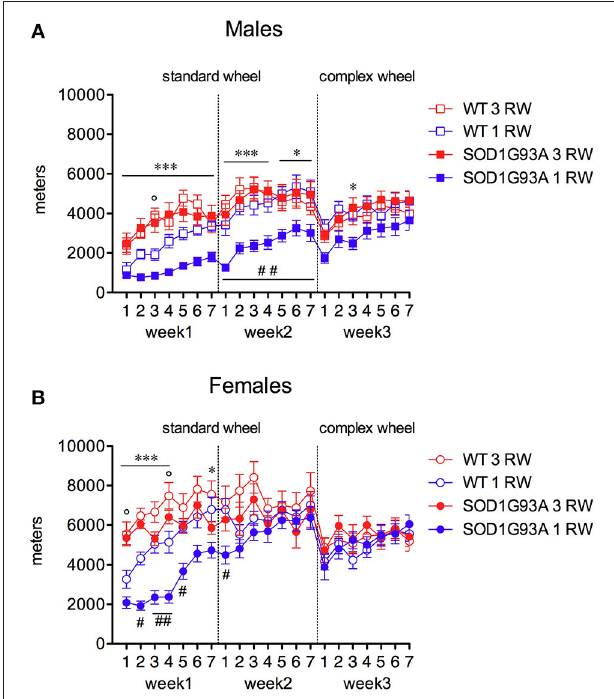
FIGURE 4 | Effect of exercise experience on running distance at 24–26 weeks of age. Total distance traveled (meters) on standard and complex running wheels in male and female mice at 24–26 weeks (nightly running mean ± s.e.m. across three-week’s session). (A) Males, RM ANOVA: Genotype factor, F (1,33) = 4.584, P = 0.04; Exercise factor, F (1,33) = 12.695, P = 0.001; Genotype × Exercise, F (1,33) = 6.011, P = 0.02. (B) Females, RM ANOVA: Genotype factor, F (1,34) = 3.553, P = 0.06; Exercise factor, F (1,34) = 8.789, P = 0.0055; Genotype × Exercise, n.s. Bonferroni post-hoc ’s: *** P < 0.001, * P < 0.05 1 RW vs. 3 RW in SOD1G93A low-copy mice; ◦ P < 0.05 1 RW vs. 3 RW in WT mice; # P < 0.05; ## P < 0.01 WT vs. SOD1G93A low-copy in